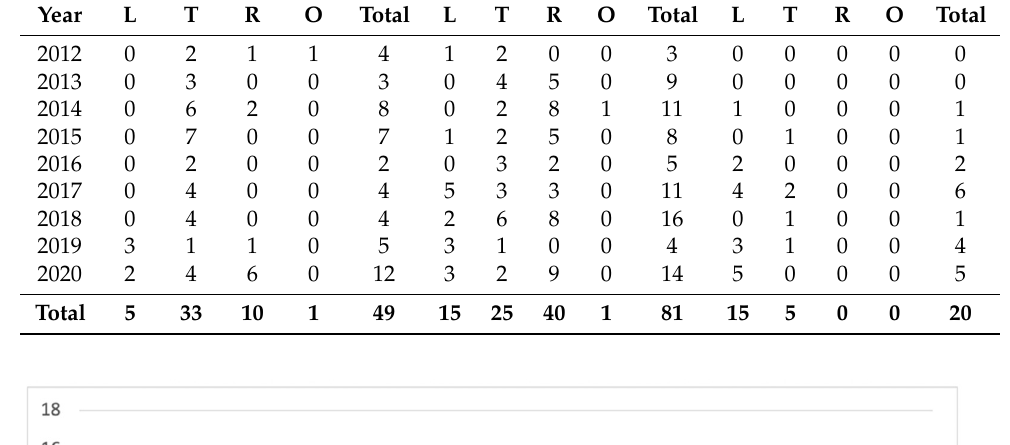
Table 2. Distribution of visualization, LADM and non-LADM related standardization sub-topics. L = Legal, T = Technical, R = Registration, O = Organizational.